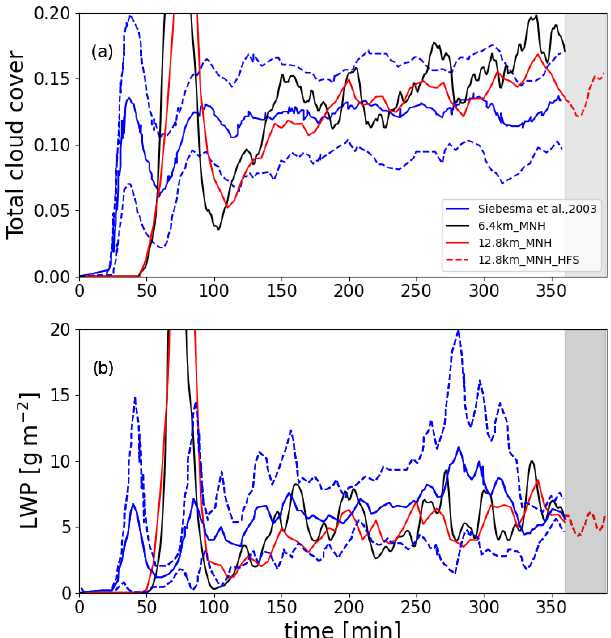
Figure 1. Temporal evolution of (a) total cloud cover and (b) liquid water path from the Siebesma et al. (2003) intercomparison (blue lines; solid line for the mean and dotted line for the ± standard de- viation). The black line is for the 6.4km_MNH domain and the red line for the 12.8km_MNH domain. Gray shaded area corresponds to Meso-NH high-frequency outputs